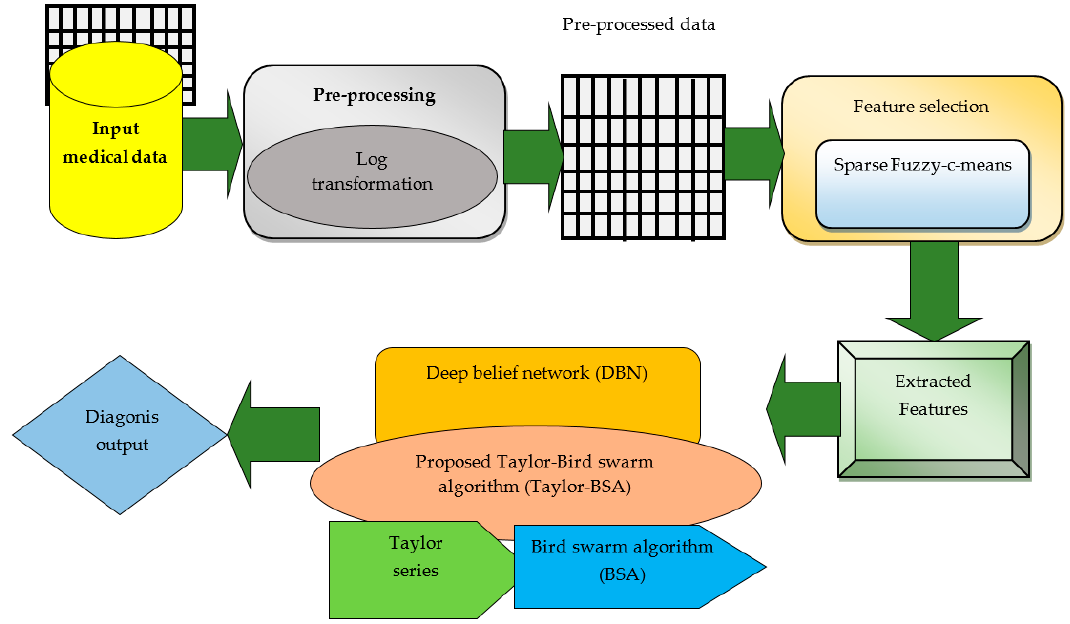
Figure 1. Schematic view of the proposed Taylor-based bird swarm algorithm (Taylor-BSA)–deep belief network (DBN) for heart disease